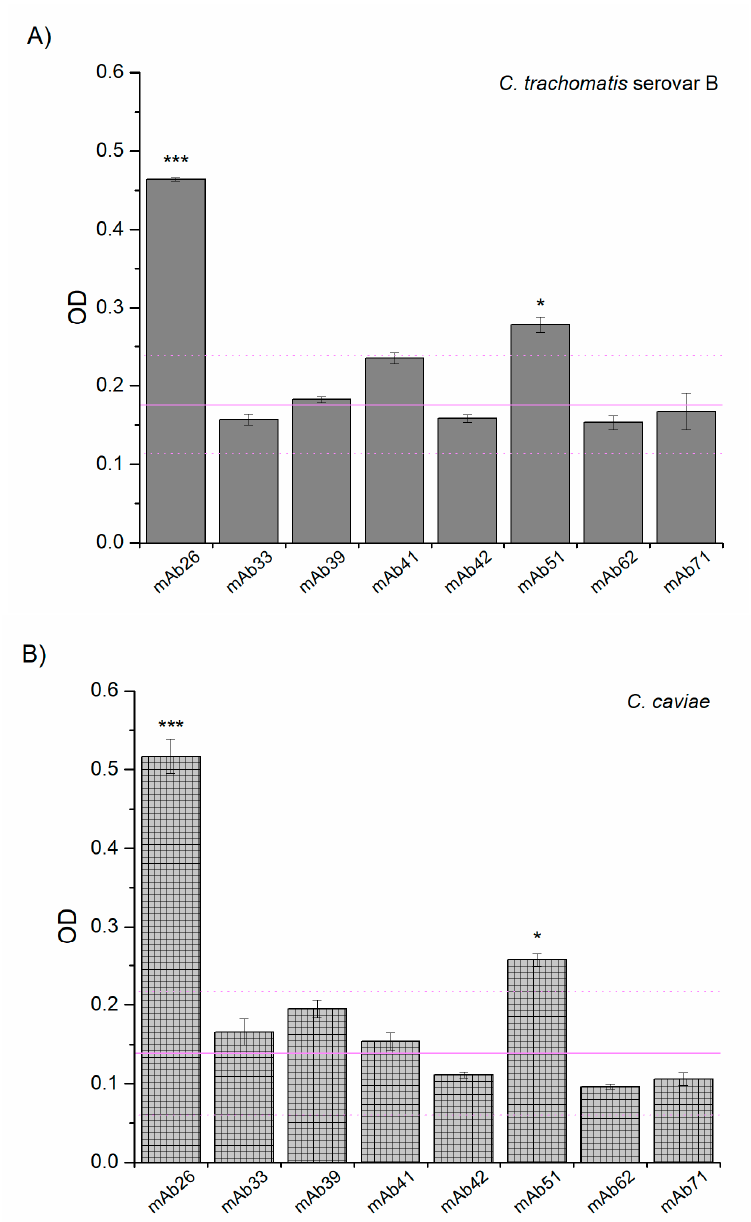
Figure 2. Reactivity of tetanus-specific monoclonal antibodies (mAbs) with C. trachomatis serovar B ( A ) and C. caviae ( B ). Threshold binding was determined with respect to mAbs other than mAb26 and mAb51 and presented as a mean + 2SD (light magenta solid / doted lines). All samples were assessed in triplicate and results presented as a mean ± S.E; * p < 0.05, *** p < 0.001 compared to the threshold binding.